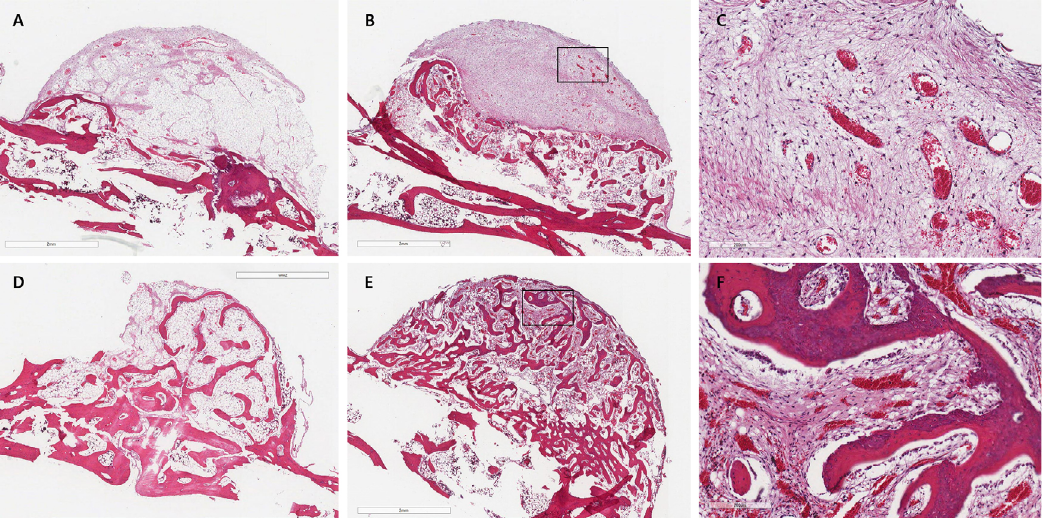
Specimen from experimental group I at week 6 (A, magnification x1.5, scale bar 2mm) and 12 (B, magnification x1.5, scale bar 2mm; C, box area in image B, magnification x10, scale bar 200 m m), and experimental group II at week 6 (D, magnification x1.5, scale bar 2mm)